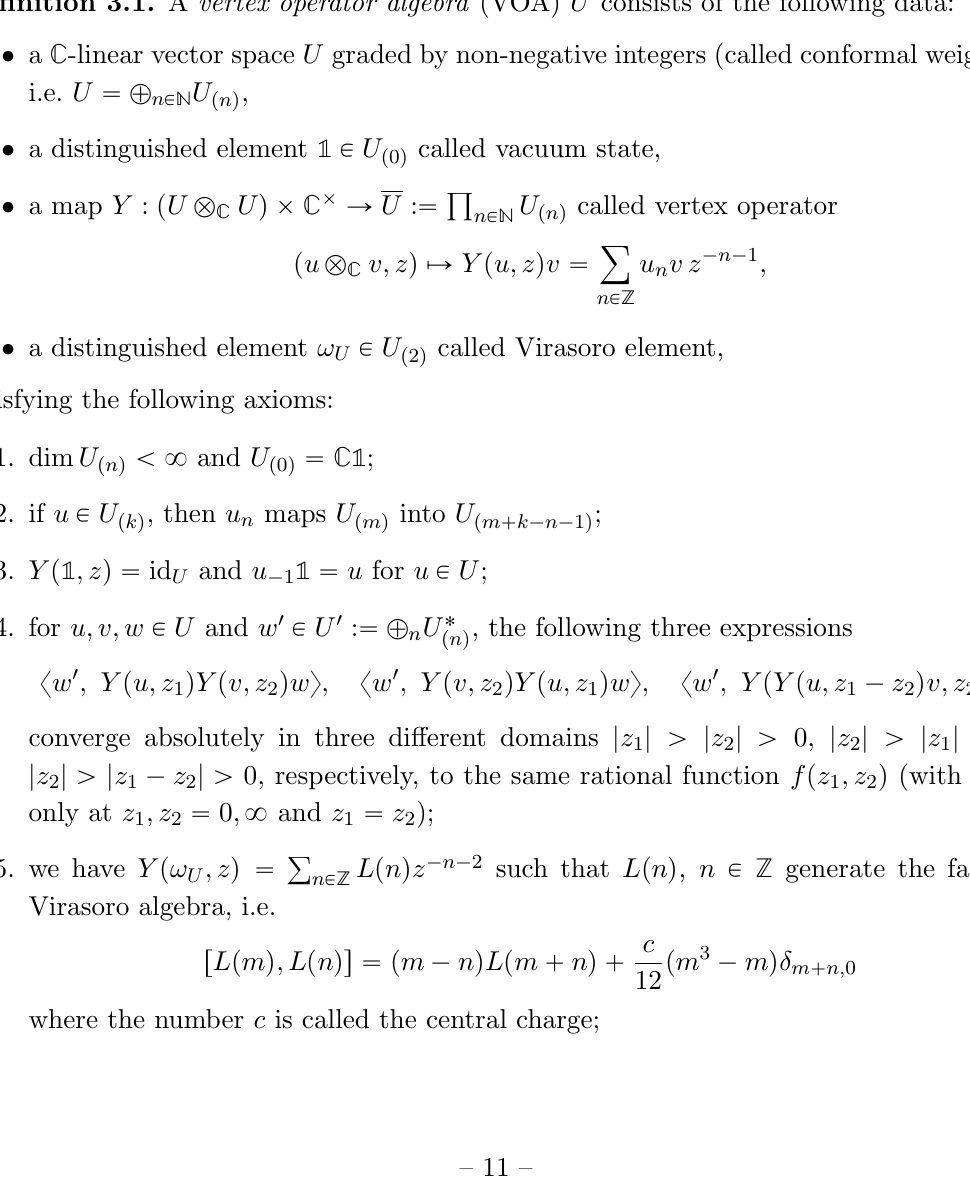
Figure 3 . This picture depicts a 2d topological order p C ; c q on a 2-disk, together with a 1d gapless edge, propagating in time. A chiral (cid:12)eld (cid:30) p z q P U is depicted on the 1+1D world sheet. for a review). In this work, we use the following working de(cid:12)nition of a VOA, which is sometimes called a CFT-type VOA. We avoid to use formal variables that are commonly used in mathematics